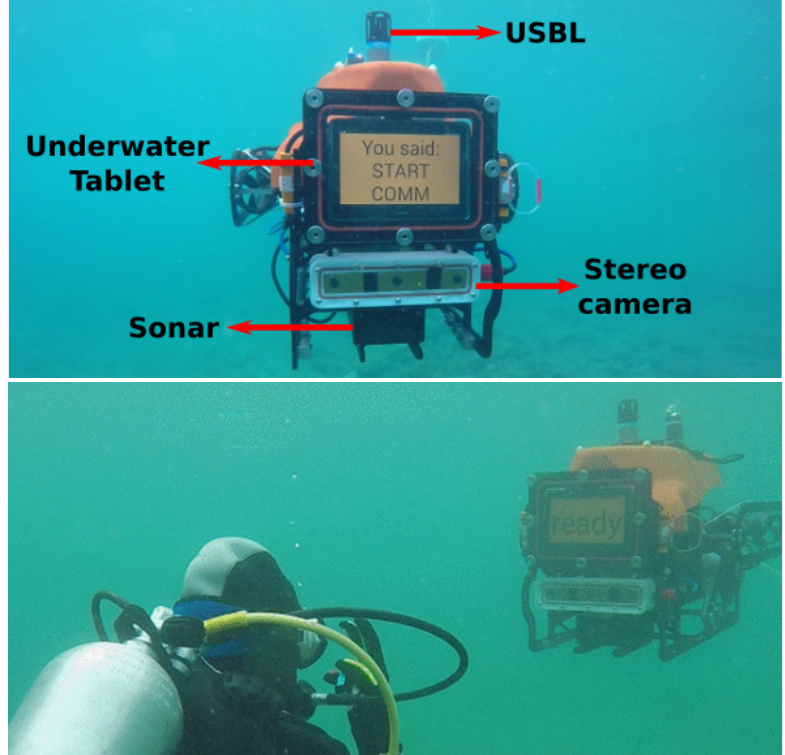
Figure 1. (Top) the BUDDY-AUV equipped with sensors to monitor the diver: Blueprint Subsea X150 USBL (Low Wood, Ulverston, UK), ARIS 3000 Multibeam Sonar (Chesapeake, VA, USA), BumbleBeeXB3 Stereo Camera (Richmond, BC, CAN), Underwater Tablet; (Bottom) diver issuing gesture commands to the